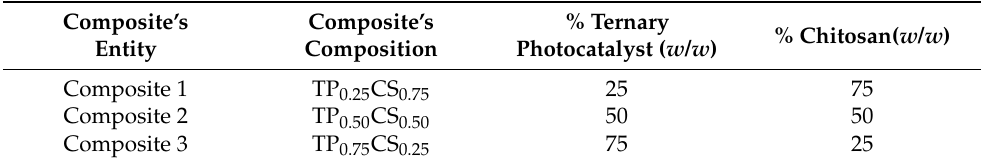
Table 1. Nanocomposites with varying ratio of ternary photocatalyst and chitosan .